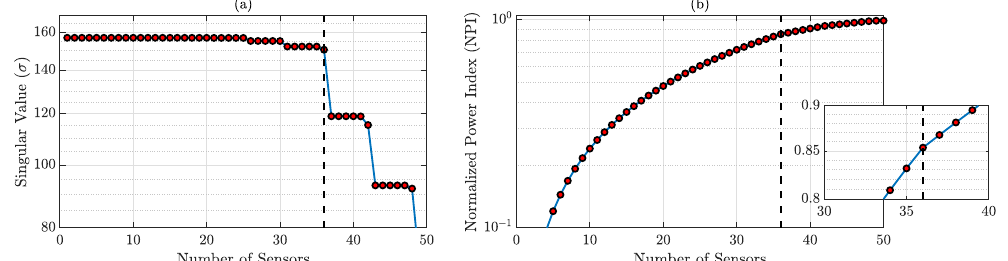
Figure 8. ( a ) SVs of the physics-guided basis matrix; the most dominant values are until 36; ( b ) NPIs for different sensor numbers. NPI = 0.8537 when the sensor number is 36 (shown in the zoomed- in version).